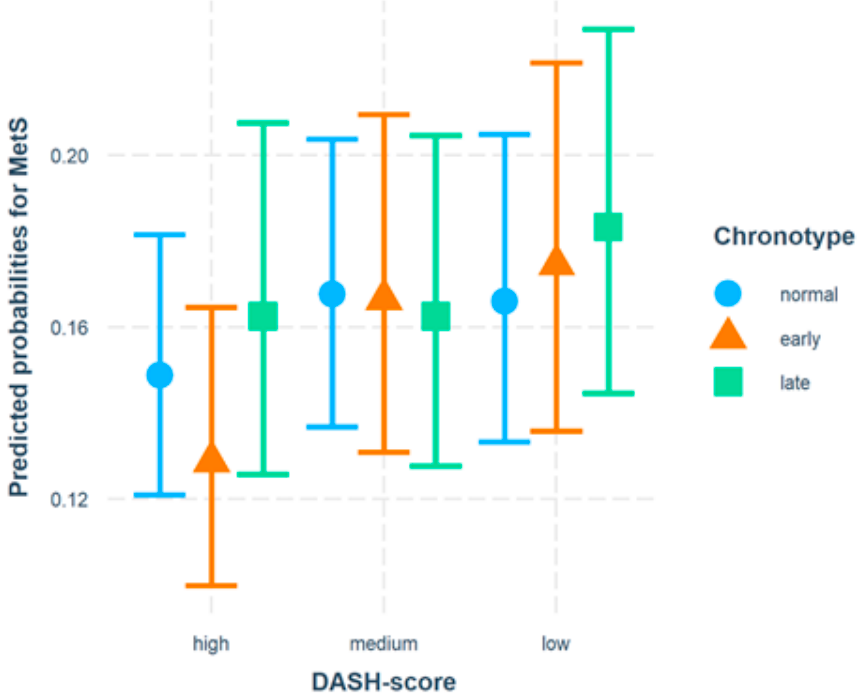
Figure 1. Multiple logistic regression with an interaction term between DASH score and chronotype with metabolic syndrome (MetS) as a dependent variable. Adjusted for age, sex, sport, school diploma, and smoking status ( n =